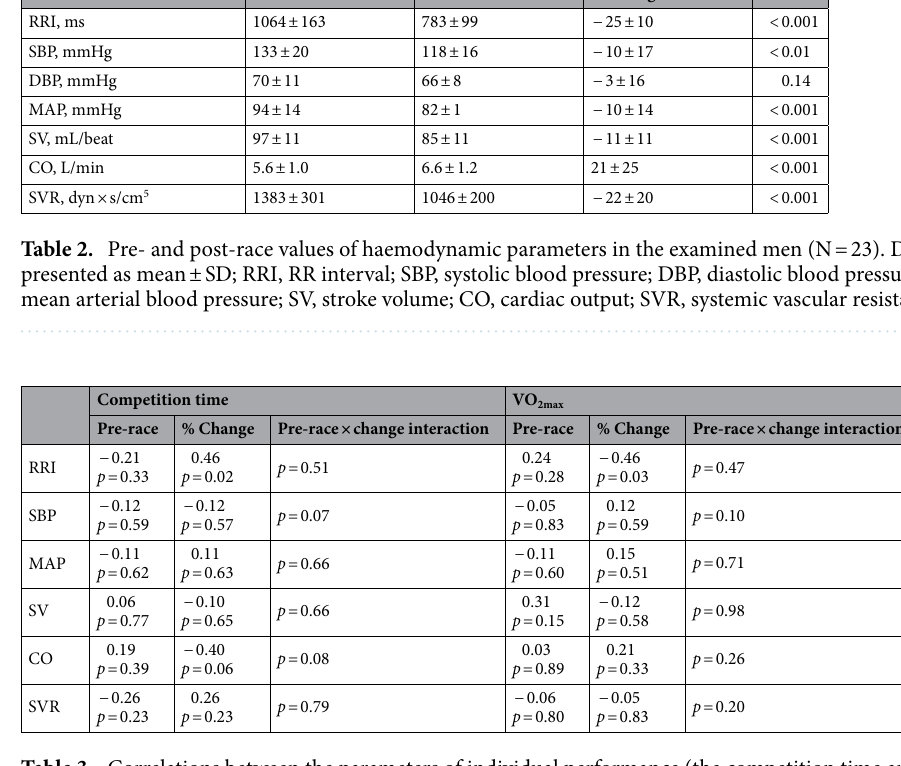
Table 3. Correlations between the parameters of individual performance (the competition time and VO 2max ) and the haemodynamic variables (pre-race values and pre-vs. post-race changes). r Pearson’s linear correlation coefficients and p values are presented for correlations with pre-race values and % change; p values for general linear model are presented for pre-race × change interaction. RRI, RR interval; SBP, systolic blood pressure; DBP, diastolic blood pressure; MAP, mean arterial blood pressure; SV, stroke volume; CO, cardiac output; SVR, systemic vascular resistance.